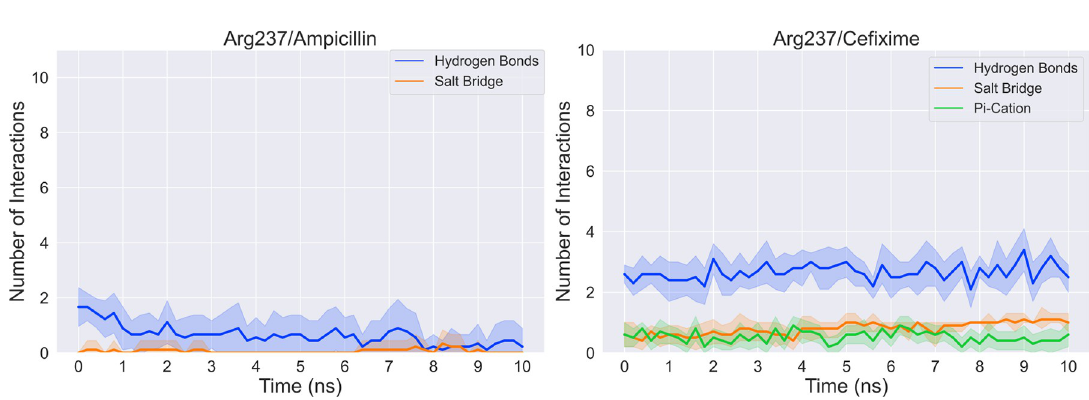
Fig 8. Analysis of the number of interactions between ampicillin or cefixime and Arg237 of TEM-Ala237Arg complexes. Data are averaged from ten replicates of MD simulations. The shading denotes the standard deviation of the number of interactions for each